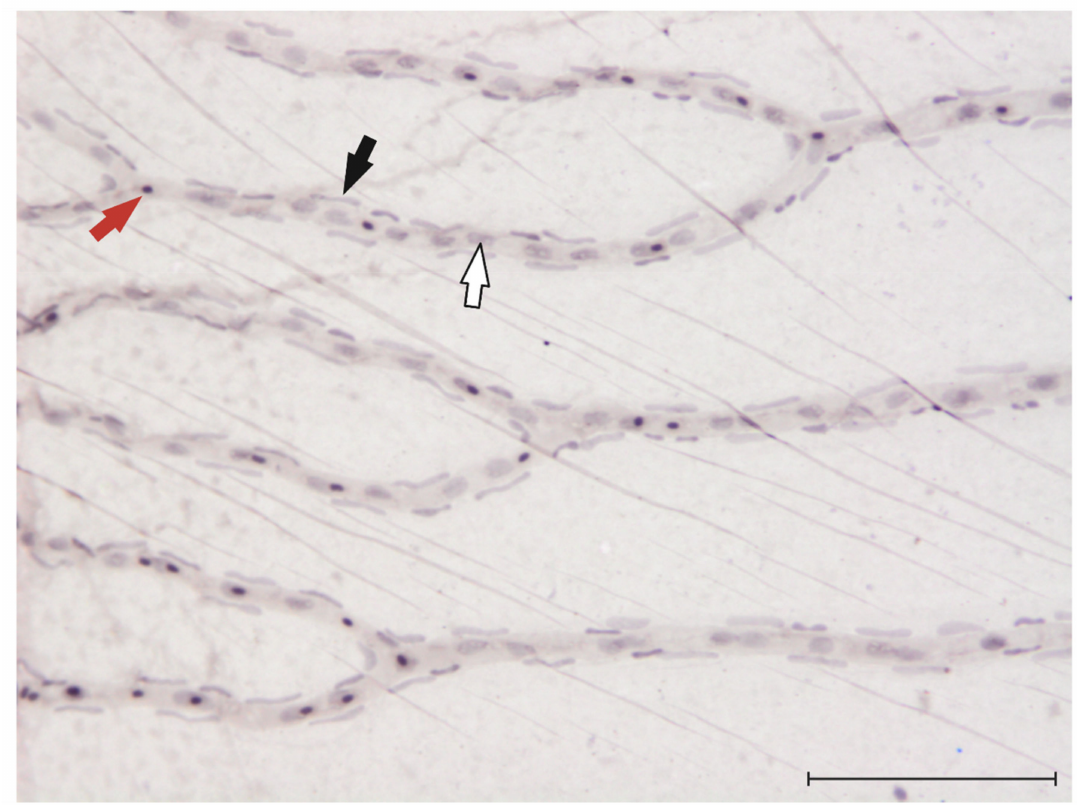
Figure 2. Visualization of endothelial cells, pericytes and erythrocytes in the zebrafish retina: 20 × magnification of the zebrafish retina after digestion in 3% trypsin [81] and haemalum stain. Red arrow: erythrocyte, black arrow: pericyte, white arrow: endothelial cell. Scale bar = 100 µ